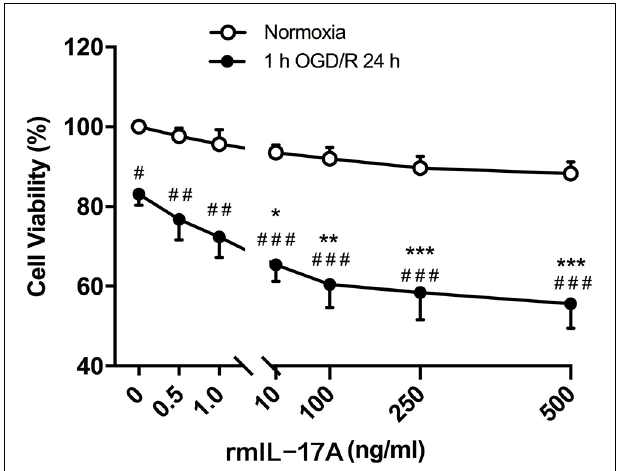
FIGURE 4 | Effect of rmIL-17A on the cell viabilities in primarily cultured cortical neurons following 1-h oxygen–glucose deprivation/reoxygenation (OGD/R) 24-h treatment. The results of 3-(4, 5-dimethylthiazol-2-yl)-5(3- carboxymethonyphenol)-2-(4-sulfophenyl)-2H-tetrazolium (MTS) assay showed that rmIL-17A could aggravate the cell viabilities of the primarily cultured cortical neurons with dose-dependent manner after 1-h OGD/R 24-h treatments ( n = 6 per group). Data are presented as mean ± SEM; * p < 0.05, ** p < 0.01, *** p < 0.001 vs. 1-h OGD/R 24 h and 0.0 ng/ml rmIL-17 treatments; # p < 0.05, ## p < 0.01, ### p < 0.001 vs. corresponding normoxic group ( n = 6 per group).